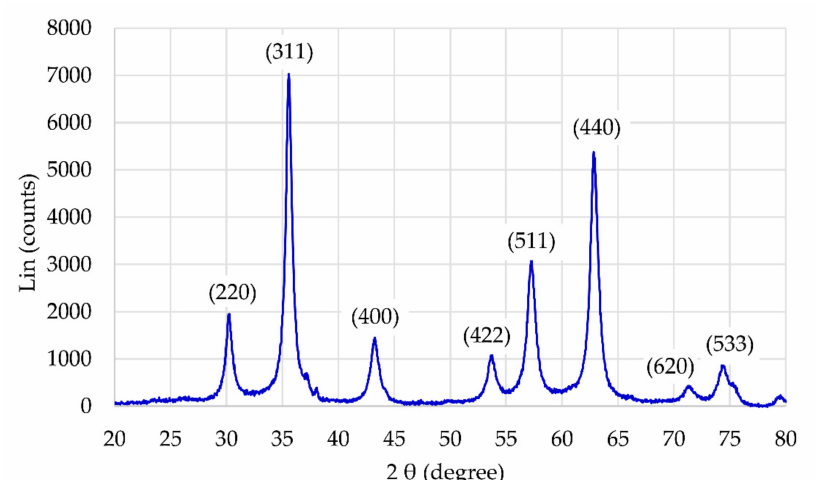
Figure 2. XRD of γ -Fe 2 O 3 NPs.